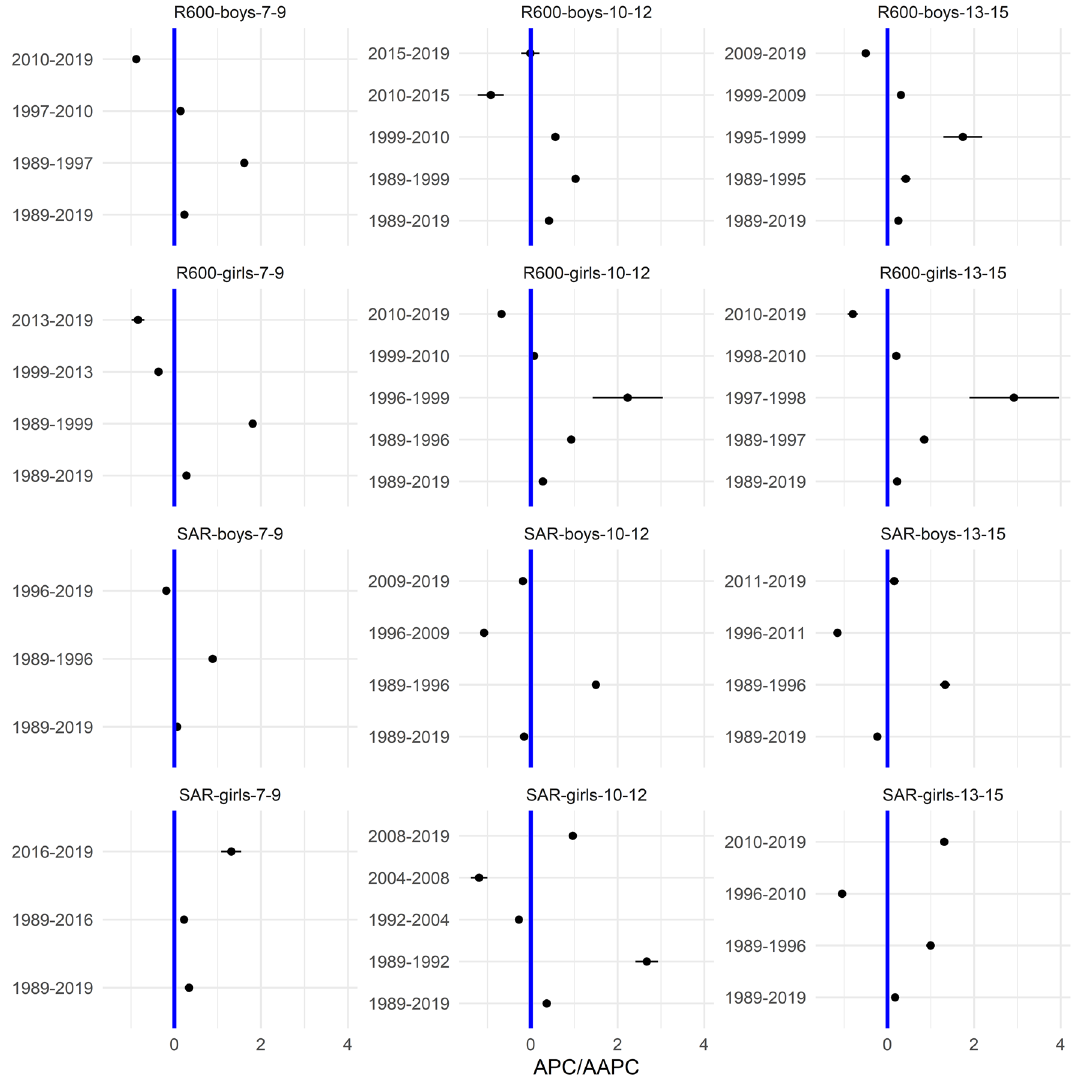
Figure 8. The estimated APC and AAPC (x-axis) with their respective 95% confidence intervals (CI) for each segment as estimated by minimizing the BIC (y-axis) for R600 and SAR by age groups (7–9-year-olds, 10–12-year-olds, and 13–15-year-olds) and gender. Negative (positive) values of APC (AAPC) for R600 imply that the children were improving (worsened) during the estimated segment (for SAR the reverse holds), when the CIs cross the vertical blue line (set at APC (AAPC) equal to zero) this implies that the results did not change during the estimated segment. See Supplementary Information for more results including the uncertainty in the estimated